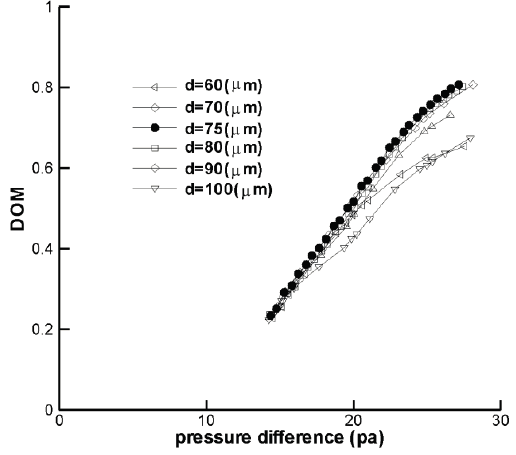
Figure 11. Effects of the clearance on the DOM relationship with pressure difference.